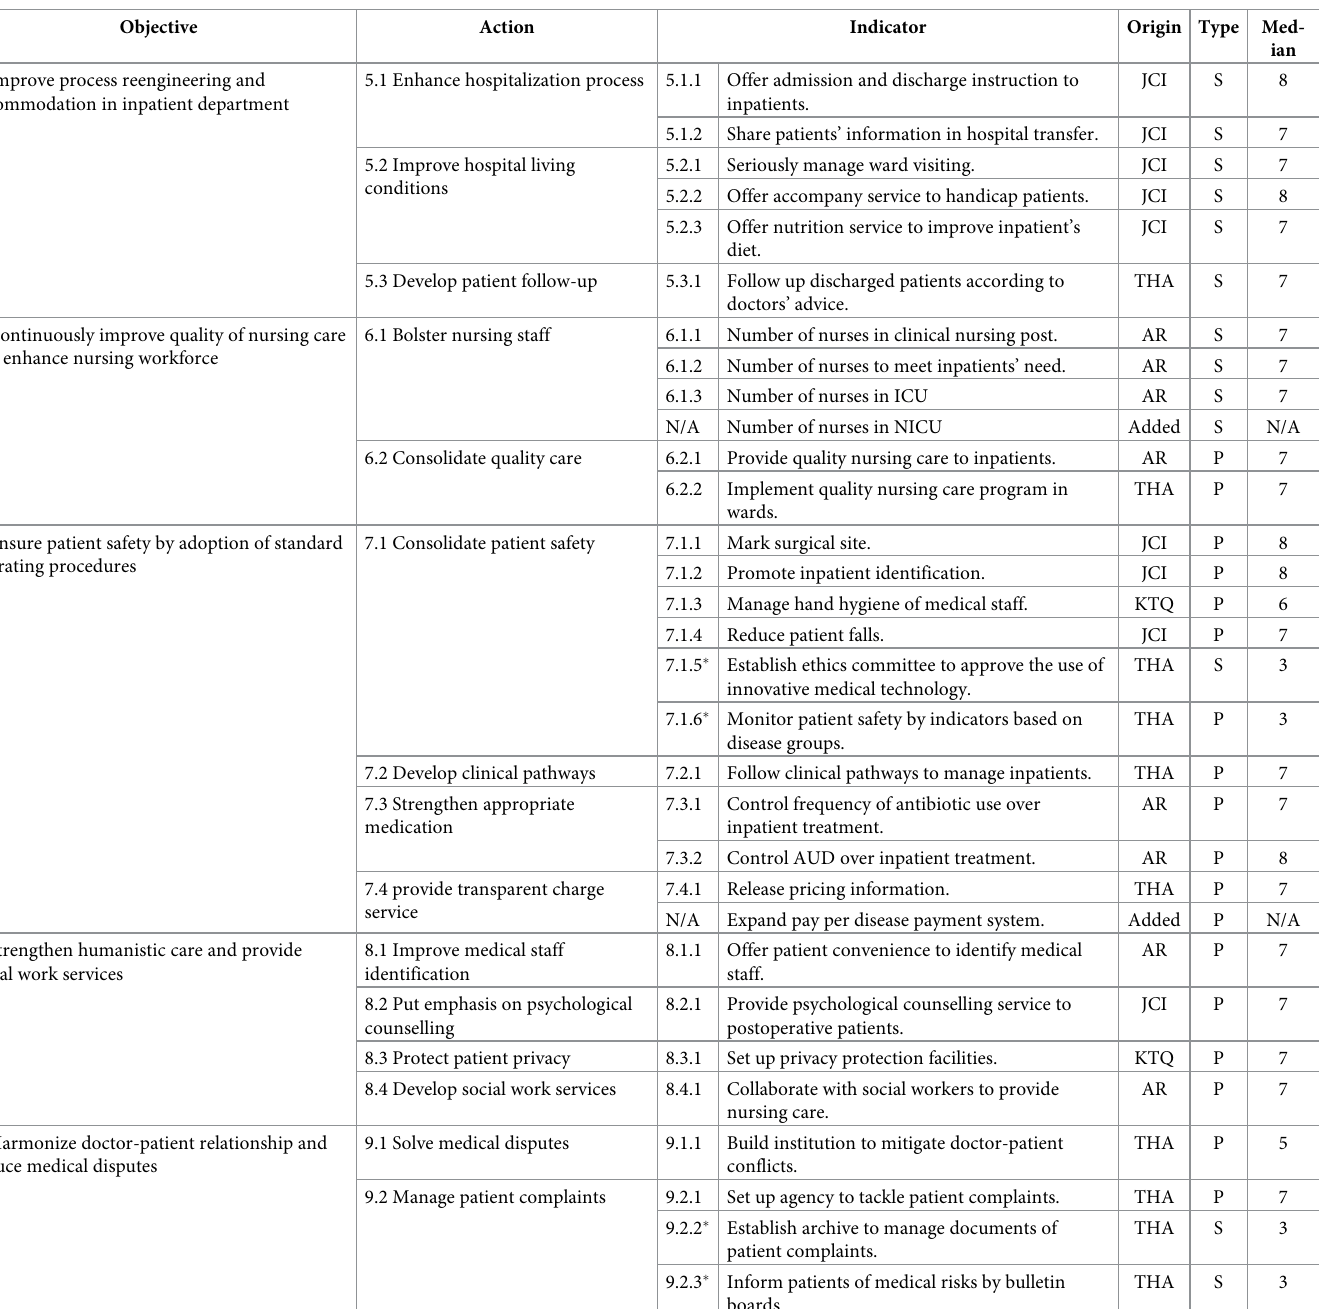
The indicators are abbreviated. The full discerptions of indicators are available in the S1